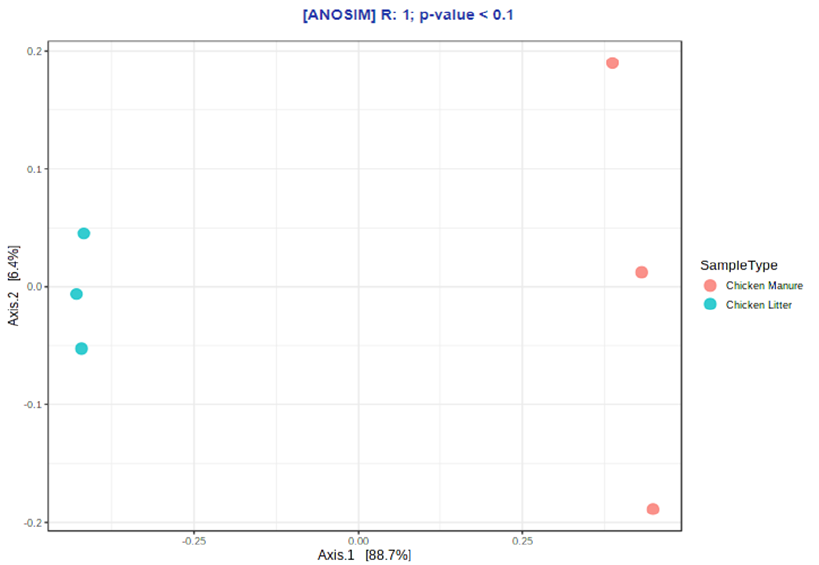
Figure 4. Principal coordinate analysis (PCoA) of microbial community compositions based on the Bray–Curtis dissimilarity matrices (ANOSIM) in collected chicken waste samples (chicken manure: CM_1, CM_2, CM_3 (orange dots) and chicken litter: CL_1, CL_2, CL_3 (blue dots)).